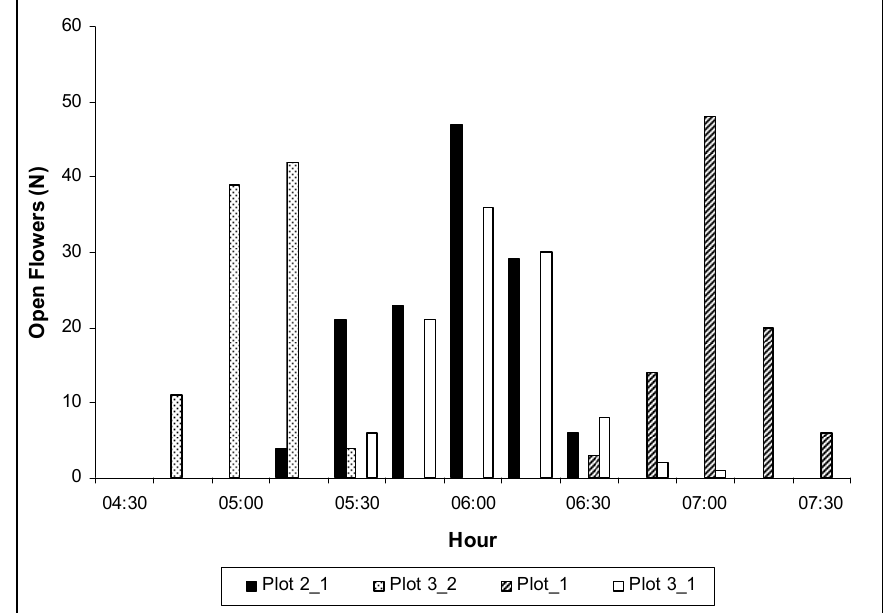
Fig 1. Number of the open flowers in Ipomoea bahiensis (Convolvulaceae), per hour interval on the Campus of Universidade Estadual de Feira de Santana, BA, Brazil between July and October